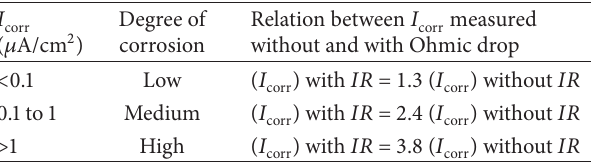
Table 4: Relation between 𝐼 various degrees of